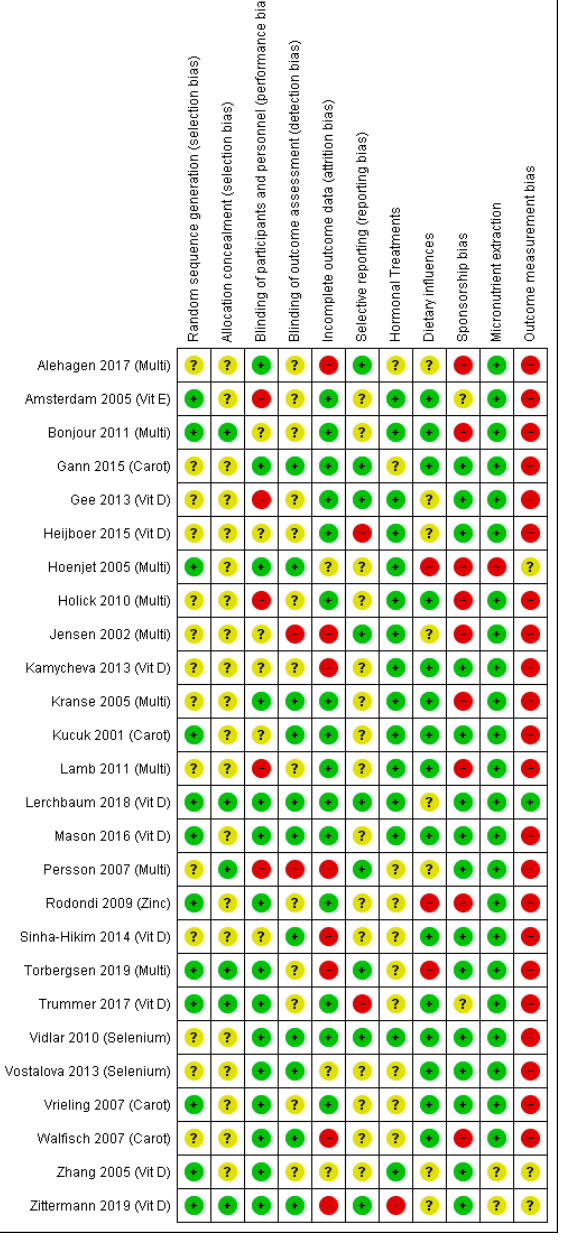
Figure 2. Risk of bias of included RCTs, assessed for each domain and each included trial, based on the Cochrane Risk of Bias tool [120]. + : low risk of bias, ?: unclear risk of bias, -: high risk of bias. Carot, carotenoids; multi, multi-nutrient; vit D, vitamin D; vit E, vitamin E. Please refer to Supplementary Table S5, E to find detailed information on the studies and reference